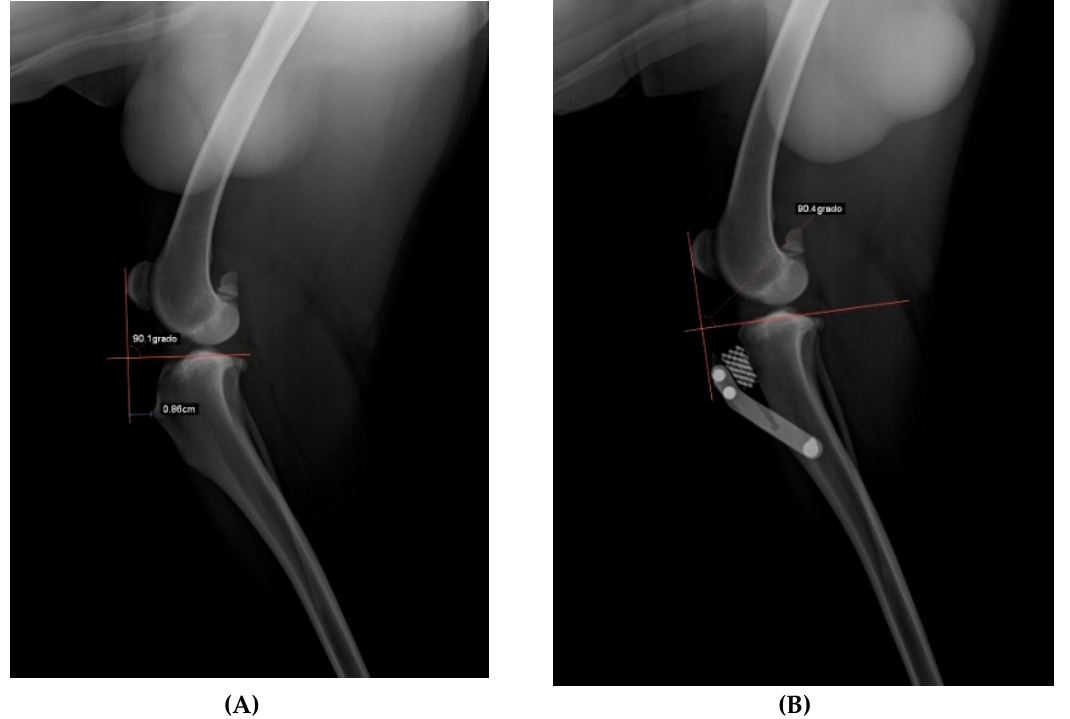
Figure 2. The radiographic planning. ( A ) Pre-operative measurement of the tibial advancement. ( B ) Radiographic aspect after surgery and post-operative measurement.